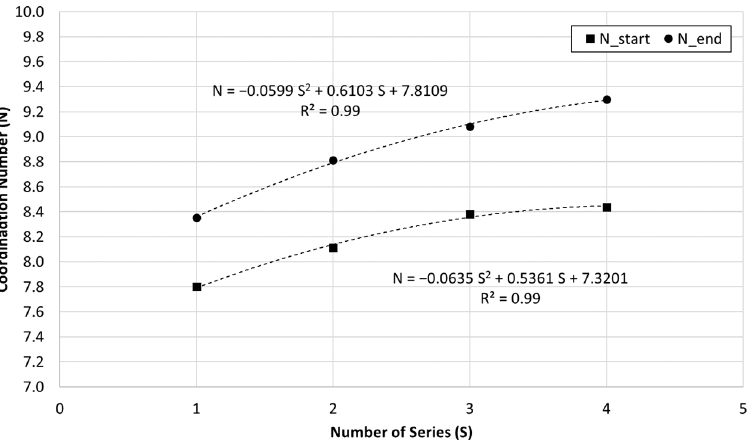
Figure 8. Variation of the coordination number (N) at the start and at the end of each series and the corresponding adjusted trend expressions.